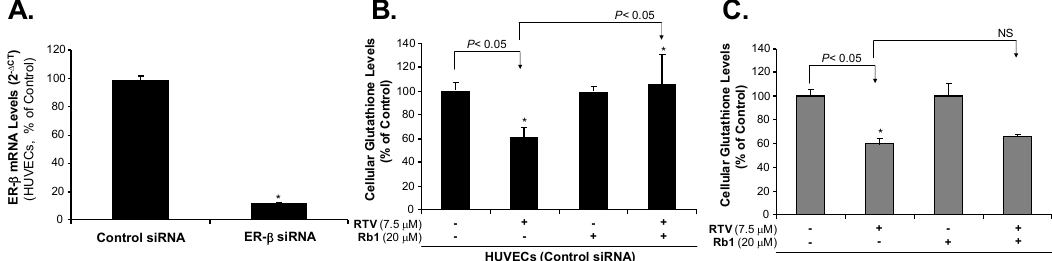
Figure 3. Effect of ER- β silencing, ritonavir (RTV), and ginsenoside Rb1 on ROS levels in HUVECs. ( A ) Effect of ER- β silencing on ER- β mRNA (real time PCR). ER- β silencing was achieved with specific oligonucleatide siRNA as compared with a scramble siRNA as a negative control (100%); ( B ) Cellular